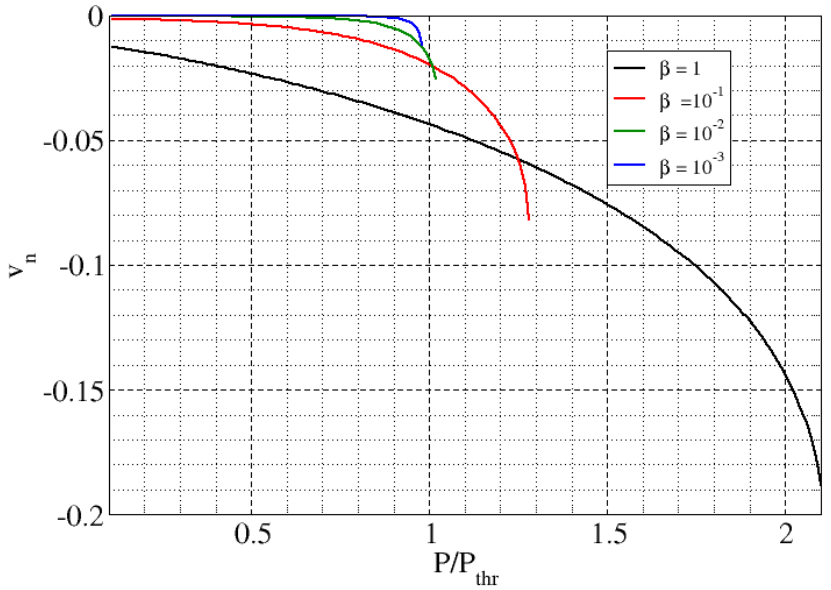
Figure 7. Photon component v n of the least stable eigenvector (matching the least stable eigenvalue in Figure 4) for differently-sized lasers. Each curve stops at the point where the eigenvector becomes com- plex, simultaneously with the appearance of an imaginary component in the corresponding